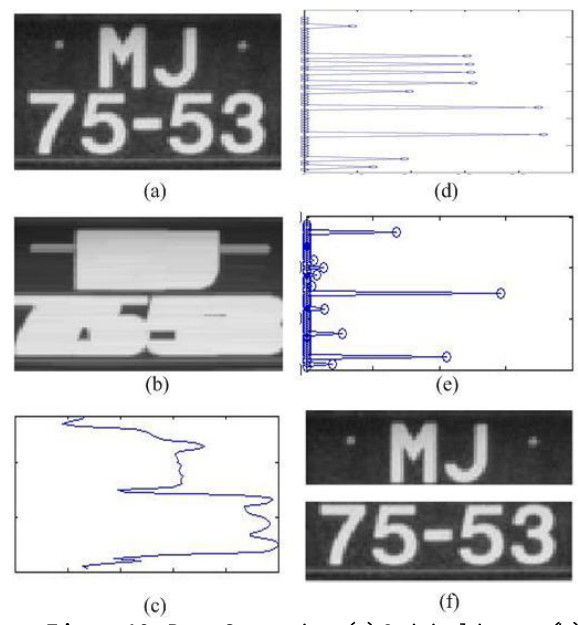
Figure 10: Row Separation. (a) Original image. (b) Dilated image. (c) Horizontal projection. (d) Local minima graph. (e) Rate-of-change graph. (f) Separation